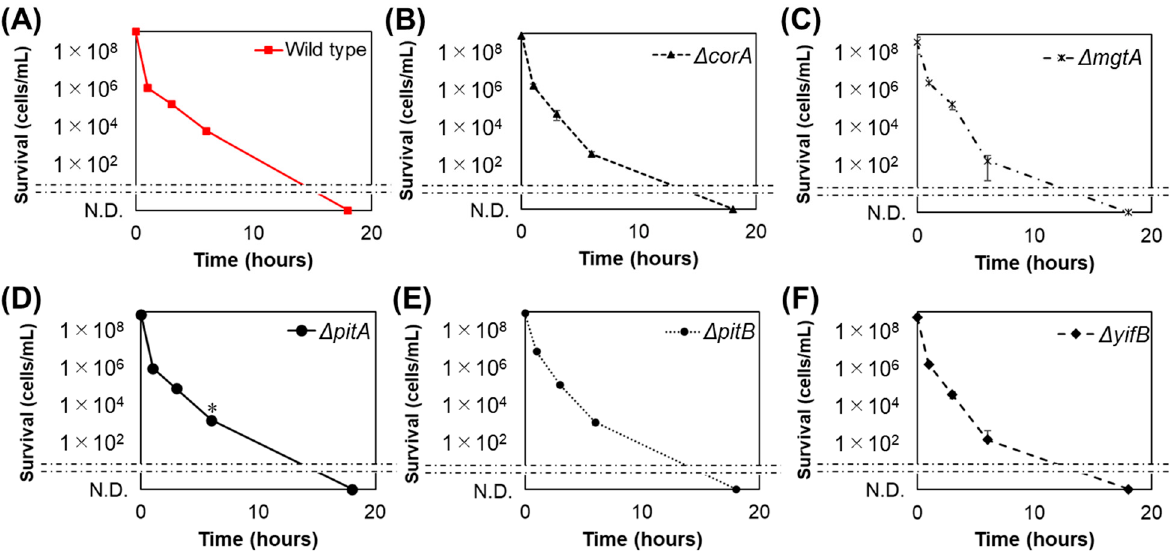
Figure 4. Bactericidal effect of NM80 against the magnesium-transport-related knockout strains: ( A ) wild type, (B) ∆ corA , ( C ) ∆ mgtA , ( D ) ∆ pitA , ( E ) ∆ pitB , and ( F ) ∆ yifB . NM80 concentration was 500 mg/L. N.D. means “not detected.” Student’s t -tests were used to compare the wild type with each mutant (* indicates a p -value < 0.05).